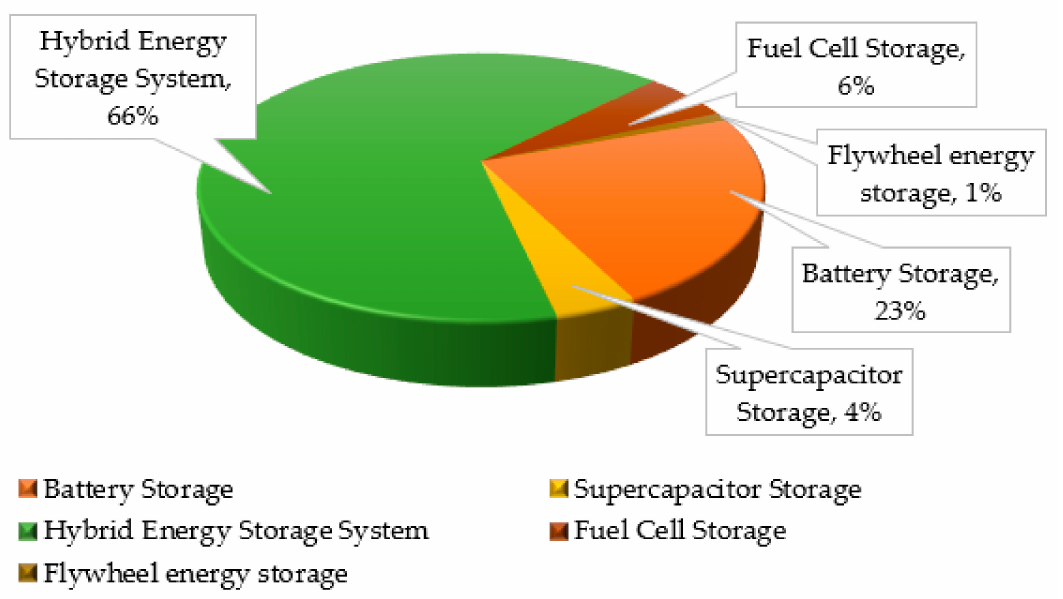
Figure 7. Classification of energy storage types from the selected